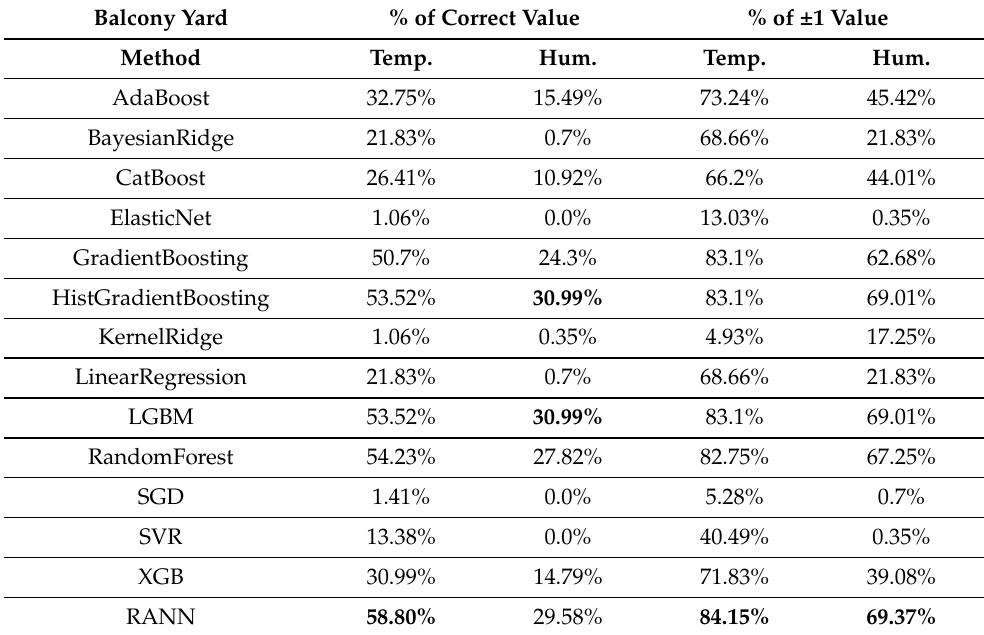
Table 3. Evaluation of algorithms for the measurements bedroom-yard balcony.